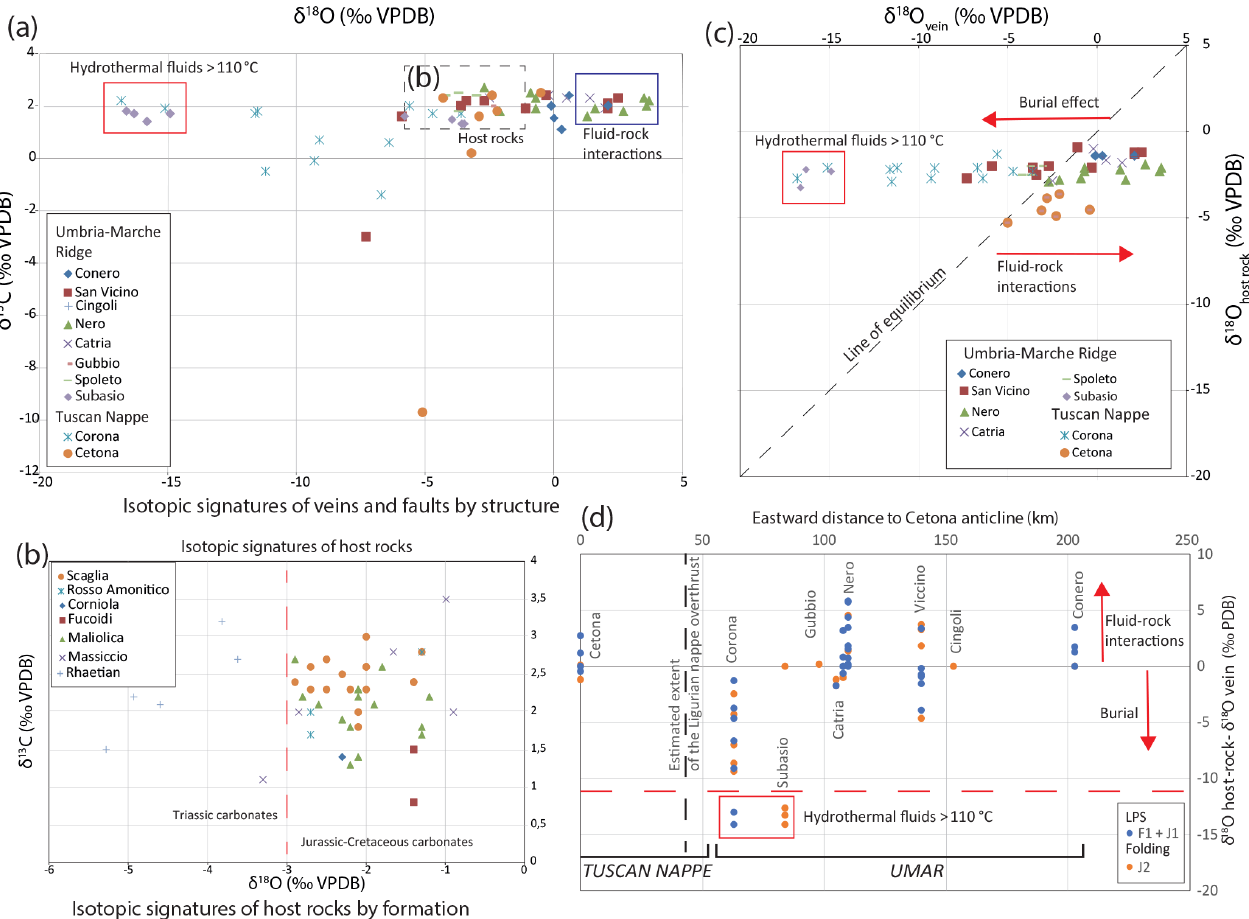
Figure 6. (a) Plot of δ 13 C vs. δ 18 O (‰VPDB) of veins represented by structure. Frames represent the different type of fluid system. (b) Plot of δ 13 C vs δ 18 O (‰VPDB) of host rocks represented by structure. (c) Plot of δ 13 C vein vs. δ 13 C host (‰VPDB) of veins represented by structures. (d) Plot of the difference between δ 18 O of host rocks and δ 18 O of veins (‰VPDB) vs. eastward distance from the Cetona Anticline towards the Adriatic Basin across the strike of the UMAR. Data are represented by tectonic sets. The proposed extension of the Ligurian nappe overthrust is reported after Caricchi et al. (2014); red frames and arrows represent the fluid systems.